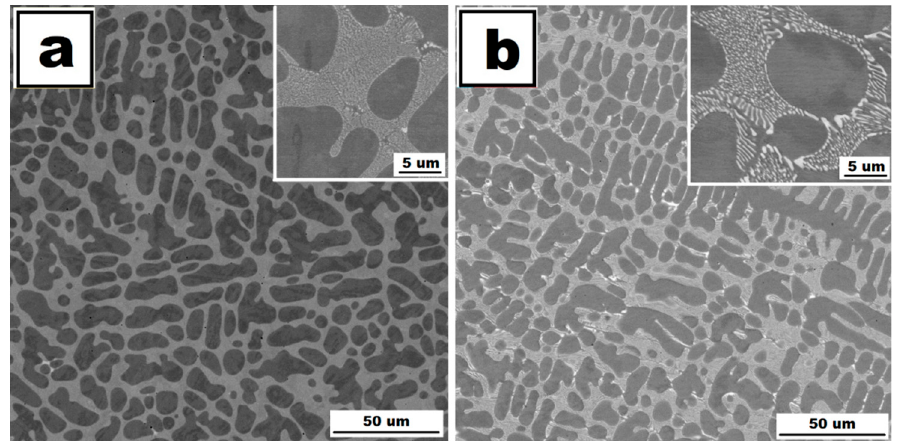
Figure 2. The structure of Fe28Al5Si alloy in as-cast state ( a ) and the structure of Fe28Al5Si alloy after annealing at 800 °C for 100 h ( b )—(scanning electron microscopes (SEM), Back-scattered electrons contrast (BSE), 20 kV).